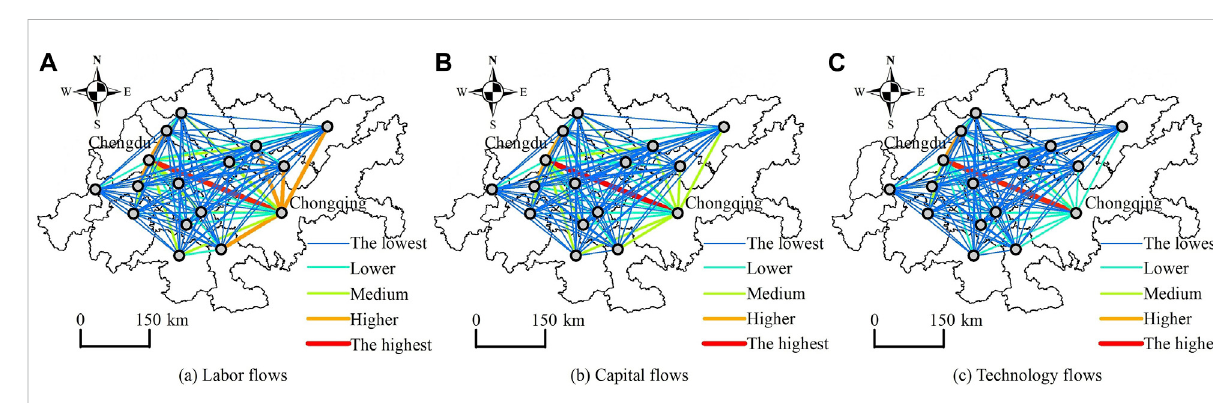
FIGURE 3 The intensity of labor, capital and technology fl ow estimated by improved gravity